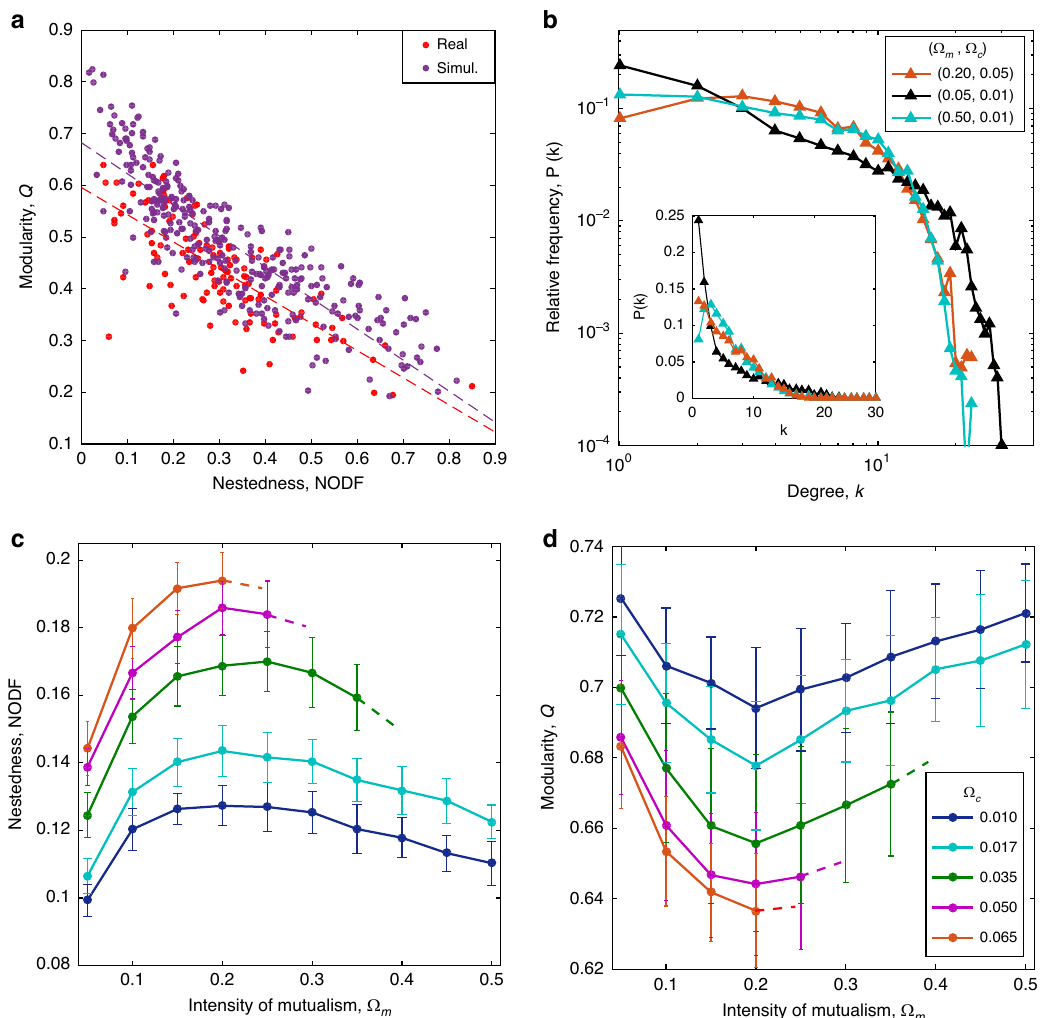
Fig. 2 Assembled network structure. a Systematic comparison of dyadic structural measures of real and generated networks. The dyadic measures (nestedness NODF, modularity Q) of an ensemble of 300 generated networks (red) show a signi fi cant overlap with those of the 144 empirical networks (blue) from the Web of Life data set and exhibit a similar negative correlation (dashed lines). For each model network, the numbers of animal and plant species and the connectance are taken from a randomly chosen empirical network, covering a large variety of network sizes (ranging from 21 to 1500) and aspect ratios (ranging from 1 to 9.8). The interaction intensities ( Ω m , Ω c ) are chosen uniformly at random from [0.01, 0.30] × [0.01, 0.30] and niche width σ from [0.01, 0.50]. b Emergent degree distribution showing a truncated power law for relatively low modularity (shown for ( Ω m , Ω c ) = (0.20, 0.05)) and a single-peaked distribution for relatively high modularity (shown for ( Ω m , Ω c ) = (0.05, 0.01) and (0.50, 0.01)). The sizes of both guilds are M A = M P = 100 and connectance C 0 = 0.058 (same for all panels). c , d Structural measures versus interaction intensities. The nestedness and modularity measures show a convex and concave dependence on the intensity of mutualism Ω m , respectively; whereas the family of colored curves show that enhancing the competition intensity Ω c contributes positively to NODF and negatively to Q. Data are obtained from 50 simulation runs and presented as mean values ± SD. The dashed tips represent infeasible equilibria. Note that different combinations of ( Ω m , Ω c ) can generate networks with the same (NODF, Q)